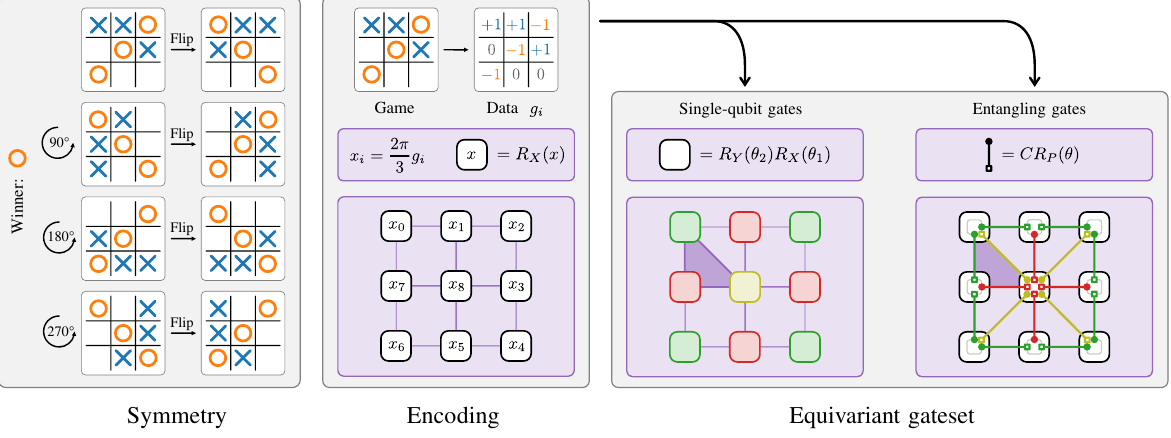
FIG. 3. The winner of a game of tic tac toe is independent of rotations and flips of the board, which means that its symmetry group is given by the dihedral group D 4 , as visualized on the left-hand side of the figure. We use a dataset of tic-tac-toe games encoded via Pauli- X rotations on nine qubits, as visualized in the second column of the figure. The three different values of a field are equidistantly encoded by using a multiple of 2 π/ 3 for the rotation angle. Using our symmetrization procedure, we obtain an equivariant gateset made up of single-qubit gates acting identically on the corners (green), edges (red), and the middle (yellow) of the board. The two- qubit gates are given by controlled rotations between corners and edges (green), edges and the middle (red), and the middle and the corners (yellow), where the control qubit is always listed first. Because of the symmetry, it is sufficient to specify the gates on one neighboring trio of corner edge and middle, as visualized by the dark purple